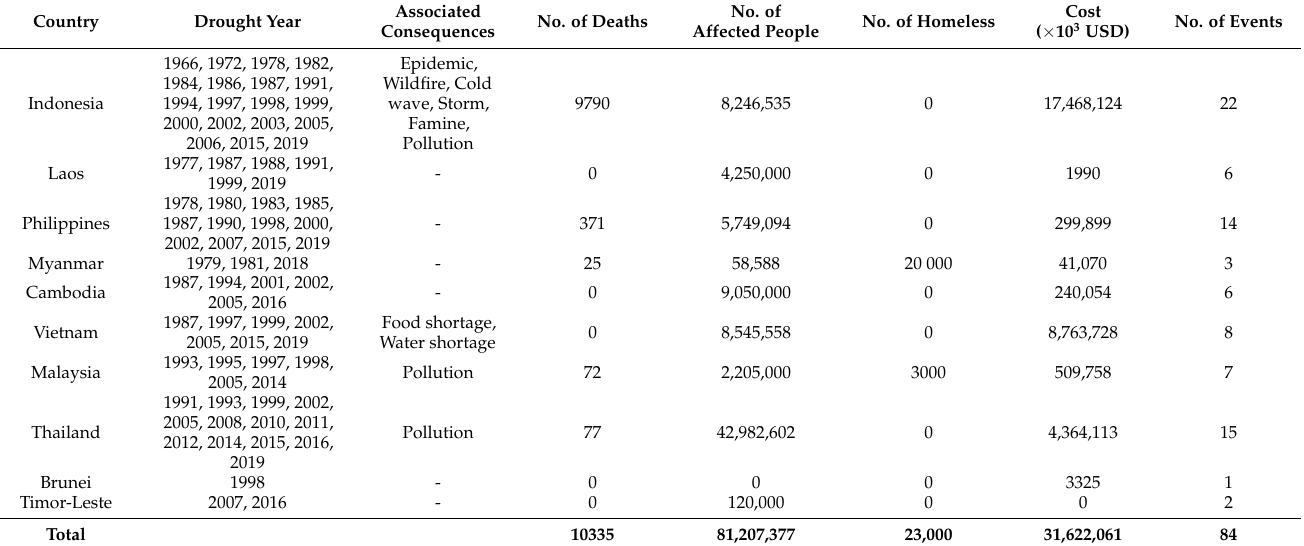
Table 1. Summary of drought impacts in Southeast Asia from 1960 to